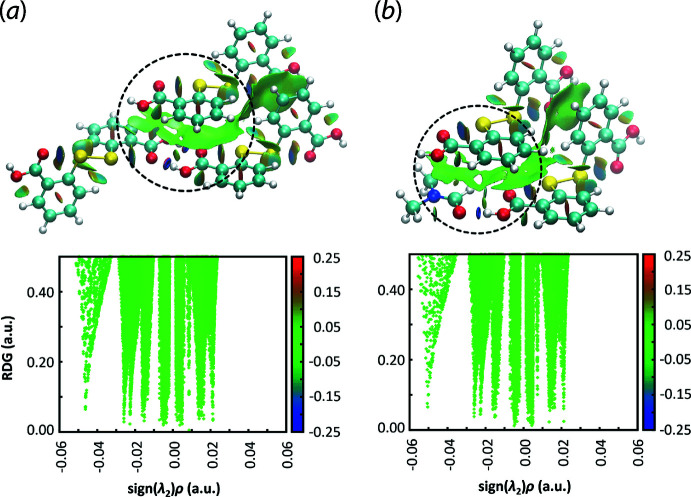
The non-covalent inter­action and corresponding RDG versus sign(λ2)ρ plots for the (a) π(C8–C13)⋯quasi-(⋯O4–C14–O3–H3O)2 inter­action and (b) π(C2–C7)⋯quasi-(O2–C1–O1–H1O⋯O5–C15–H15) inter­action. Both inter­actions are circled in black.